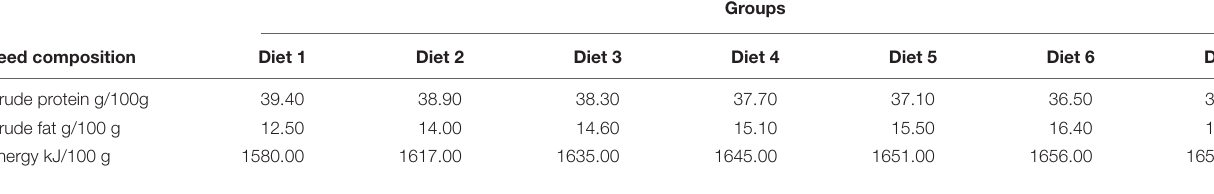
TABLE 3 | The nutrients composition of the